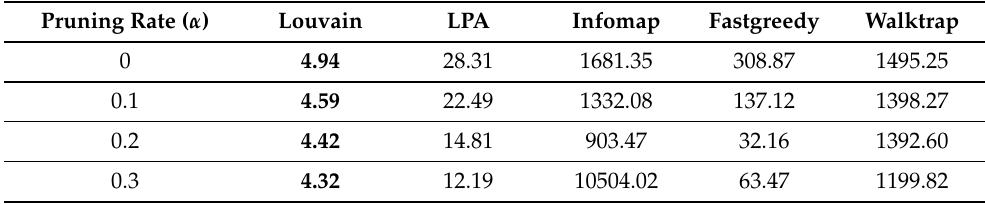
Table 3. Running times of clustering algorithms with various link pruning